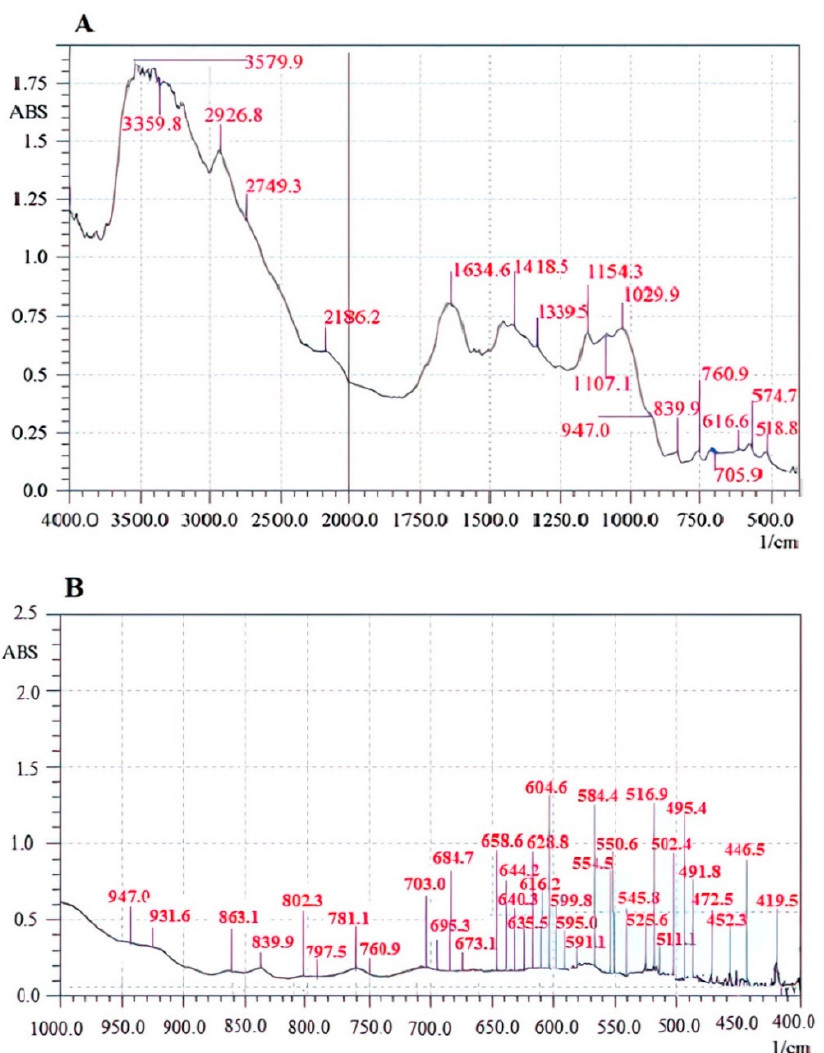
Figure 1. The FT-IR spectrum of the Se-exopolysaccharide fraction Le-P-Se. ( A ) In the scope of 4000.0 to 500.0 1/cm. ( B ) In the scope of 1200.0 to 400.0 1/cm.